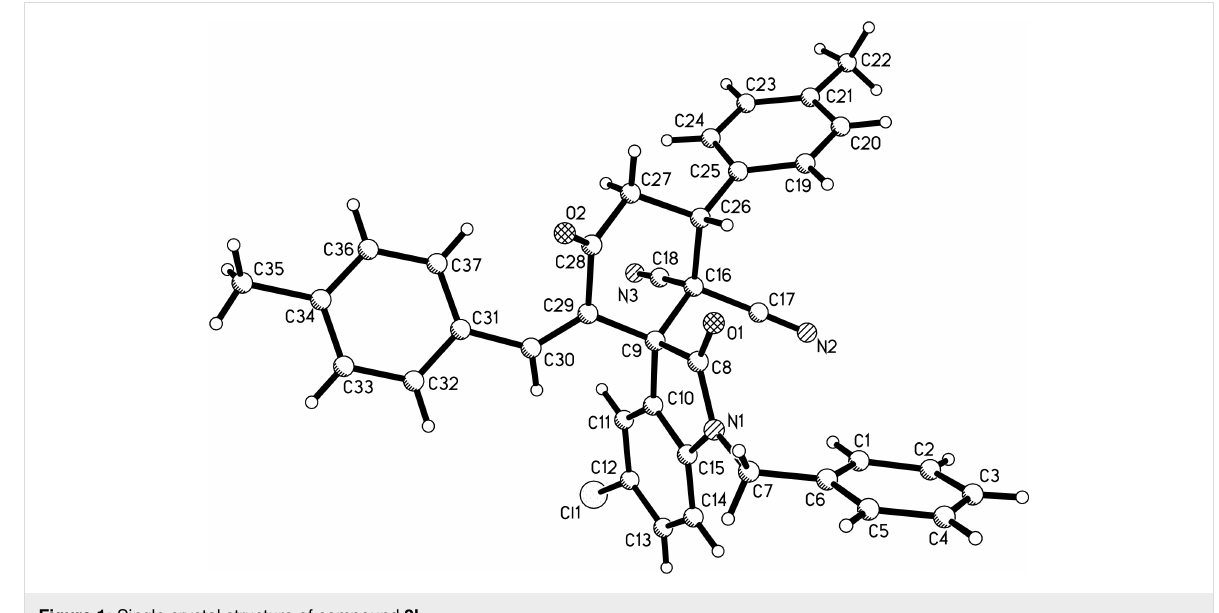
Figure 1: Single crystal structure of compound 3l .